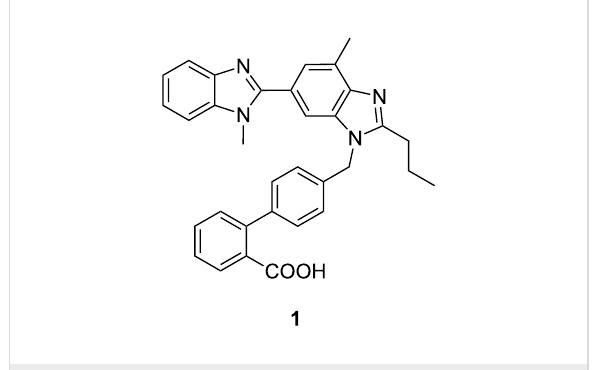
Figure 1: The angiotensin II receptor antagonist Telmisartan.